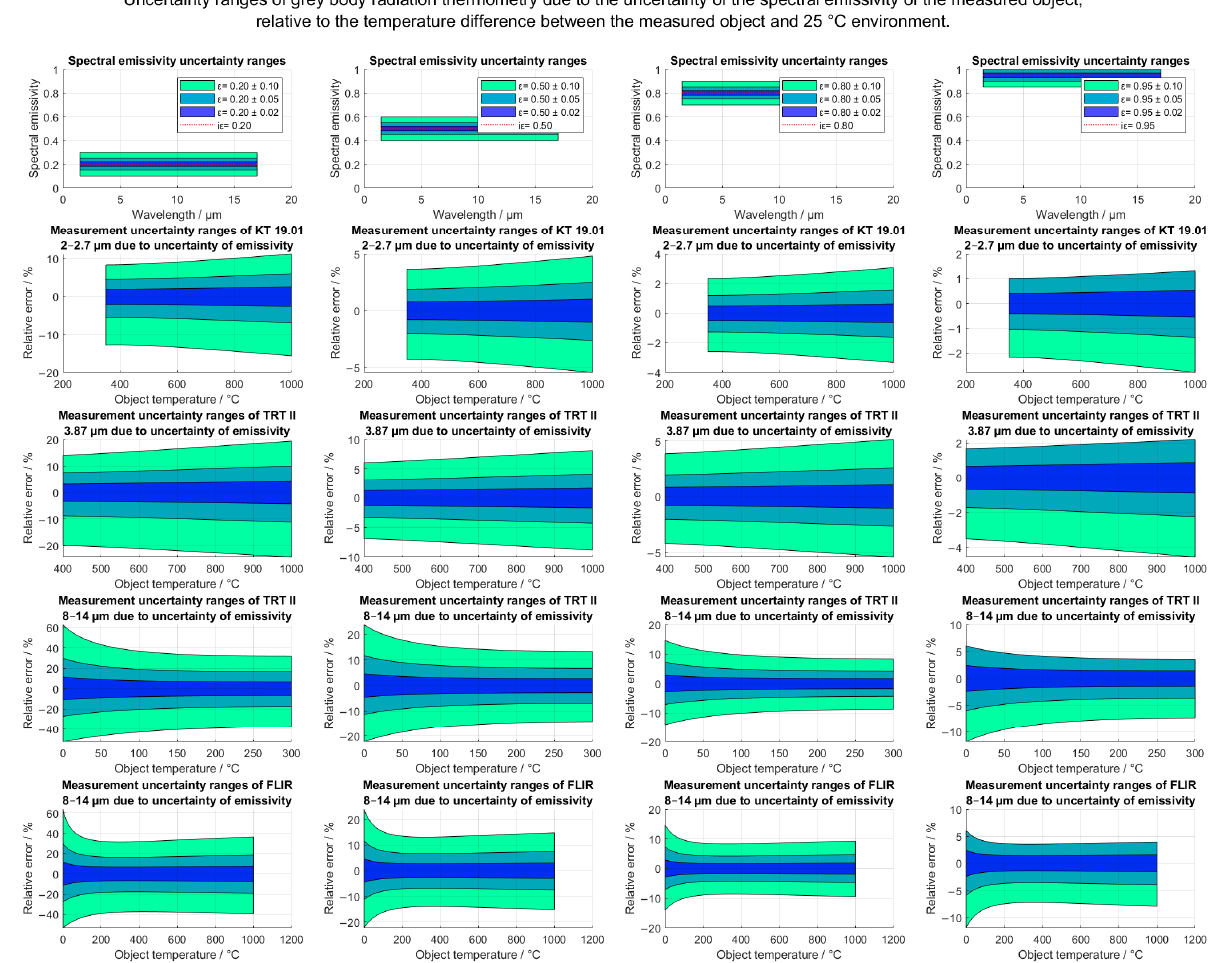
Figure 19. Relative measurement uncertainty intervals for grey body radiation thermometry of surfaces with different spectral emissivities and homogeneities, expressed relative to the temperature difference between the measured object and the 25 ◦ C environment. The uncertainty contributions correspond to the probability of occurrence of the spectral emissivity within the specified uncertainty interval. The singularity of the relative error at temperature 25 ◦ C due to the division of the absolute error with 0 ◦ C thermal difference was omitted. If the temperature of the object and the reflected radiance are equal, emissivity is irrelevant and the measurement uncertainty due to the uncertainty of the emissivity does not exist.